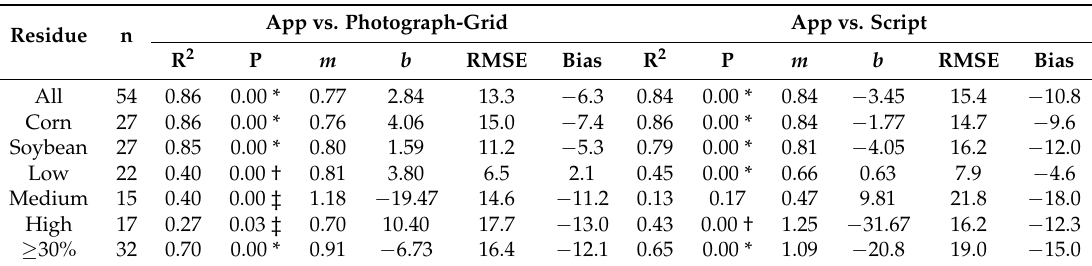
Table 3. Summary statistics of relationships between residue cover percent as determined by app compared to photograph-grid and script methods in corn and soybean fields.